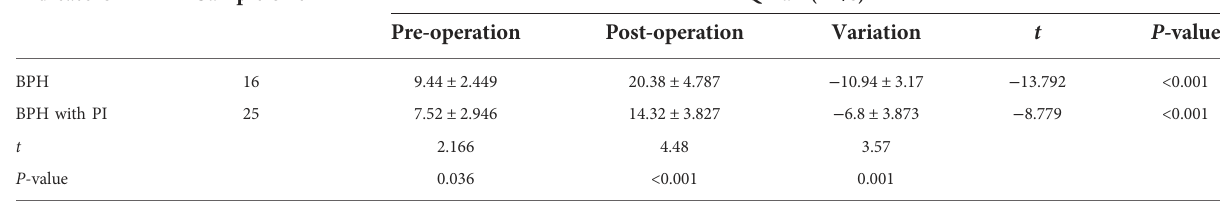
TABLE 2 Comparison of Qmax data between two groups before and after surgery (mean±SD).